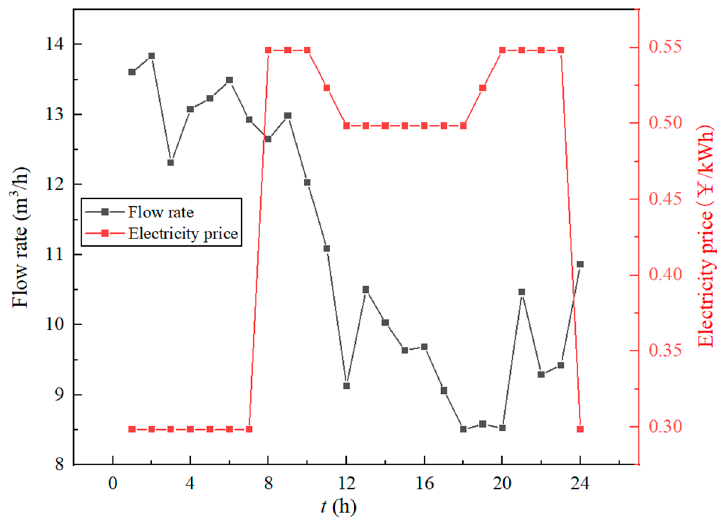
Figure 6. Buried pipe flow and electricity price in each period when the objective function is operating costs.